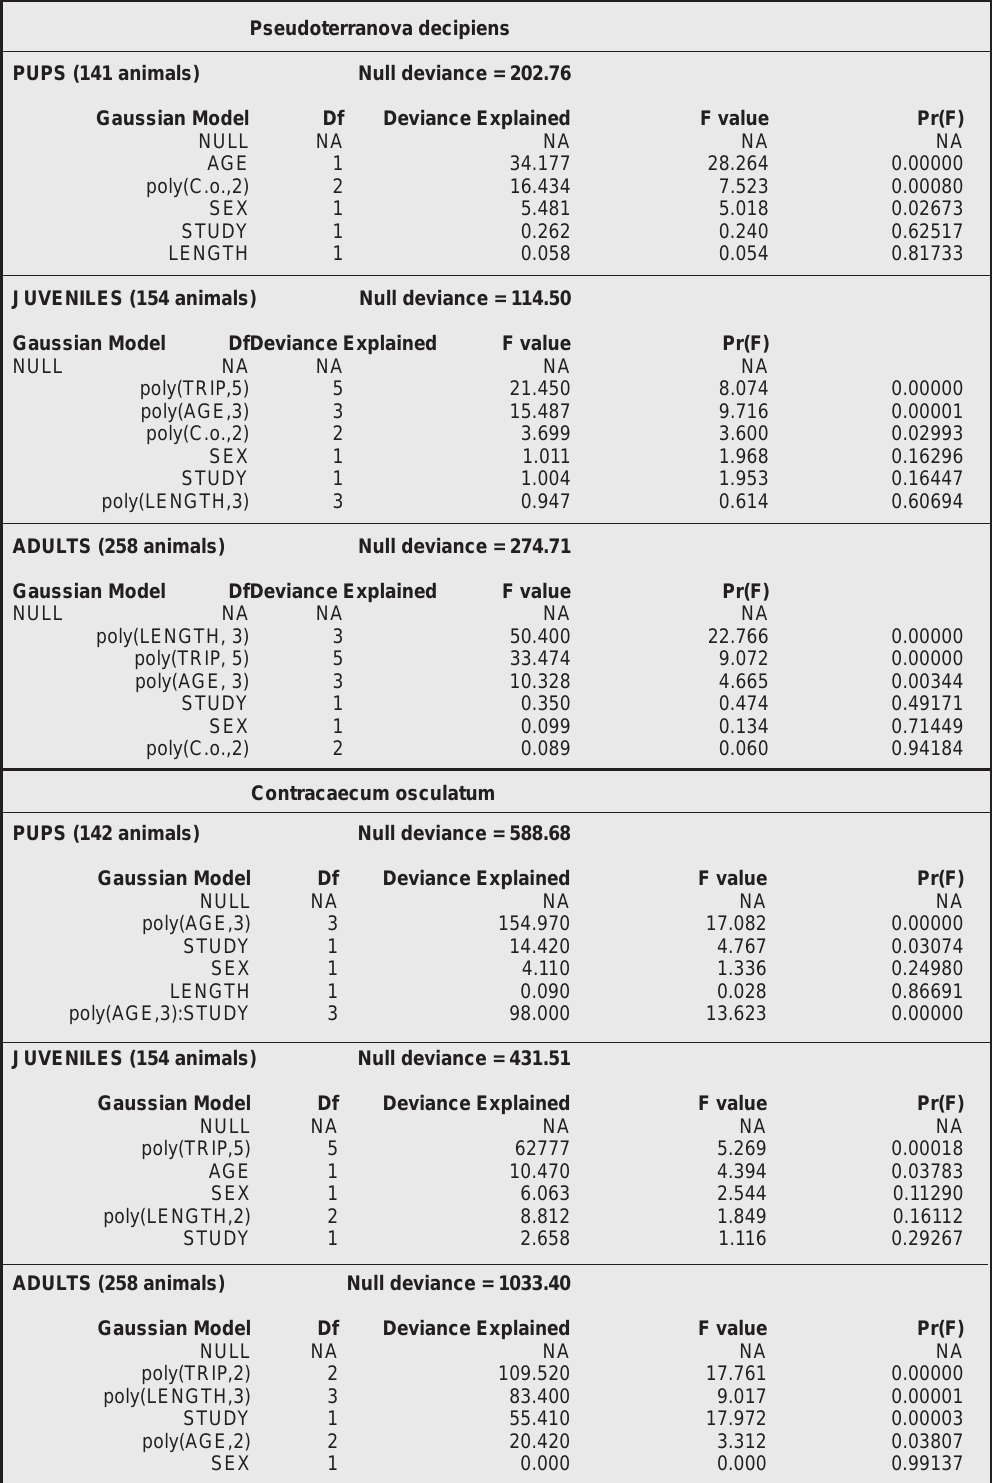
Table 2 . Analyses of deviance of log worm abundance in grey seals. Terms in italics not retained in final model. The pre- ceder “poly” defines the term as a polynomial (term,degrees of freedom). The C.o. term denotes log Contracaecum oscu- latum abundance. Insignificant interactions are not shown. The age variable denotes months in pups, and years in juveni- les and